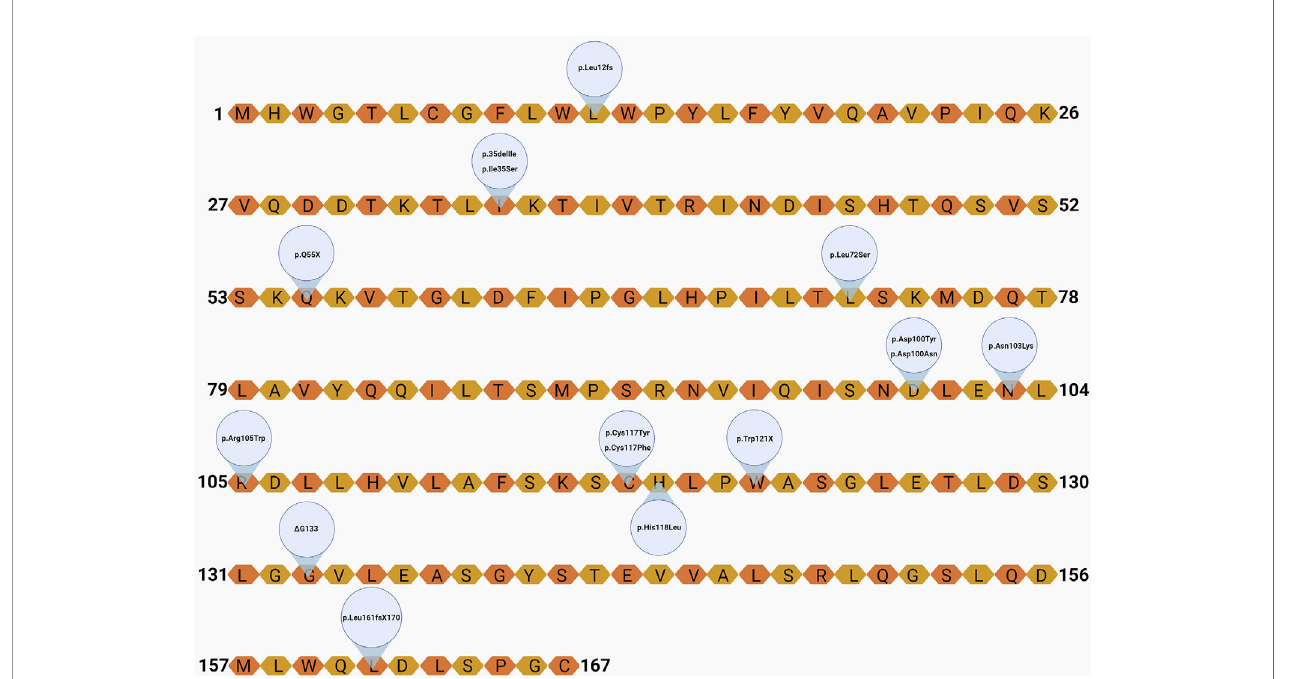
FIGURE 3 | Localization of the variants on the leptin amino-acid sequence. Created with Biorender.com.